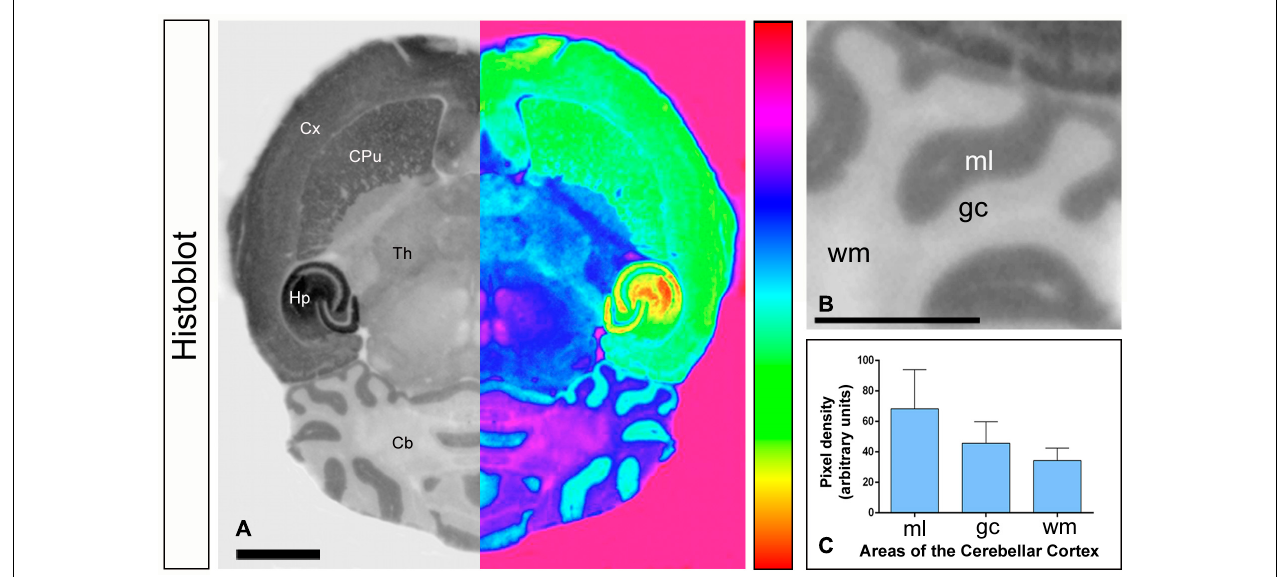
FIGURE 1 | Expression of G α o in the brain. (A–C) The protein expression of G α o was visualized in histoblots of horizontal brain sections in adult mice using an affinity-purified anti-G α o antibody. The expression of G α o revealed marked region-specific differences, with strongest immunoreactivity in the hippocampus (Hp), followed by cortex (Cx), caudate putamen (CPu) and cerebellum (Cb). Moderate expression level was detected in the thalamus (Th) [panel (A) ]. For illustration purposes, greyscale histoblot images were converted to color gradients using gradient mapping [panel (A) ]. In the cerebellum, densitometric analysis showed strong immunoreactivity for G α o in the molecular layer (ml), with lower intensity in the granule cell layer (gc) and very weak in the white matter (wm) [panels (B,C) ]. Error bars indicate SEM. Scale bars: (A) 2 mm; (B) 1